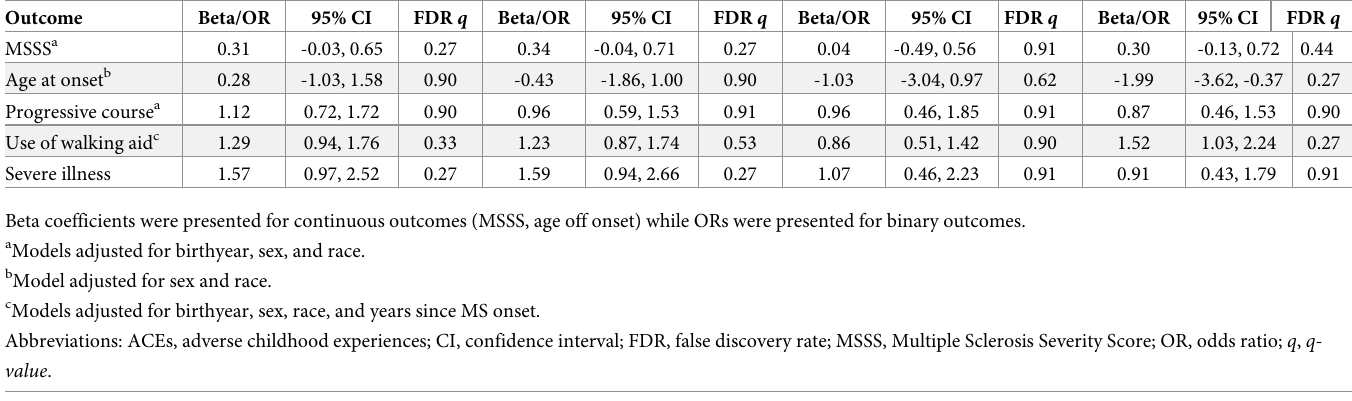
Table 4. Results from multivariable regression models of the effect of adverse childhood experiences (ACEs) during ages 0–20 years on clinical outcomes of multiple sclerosis. 1 vs 0 ACEs 2 vs 0 ACEs 3 vs 0 ACEs 4 or more vs 0